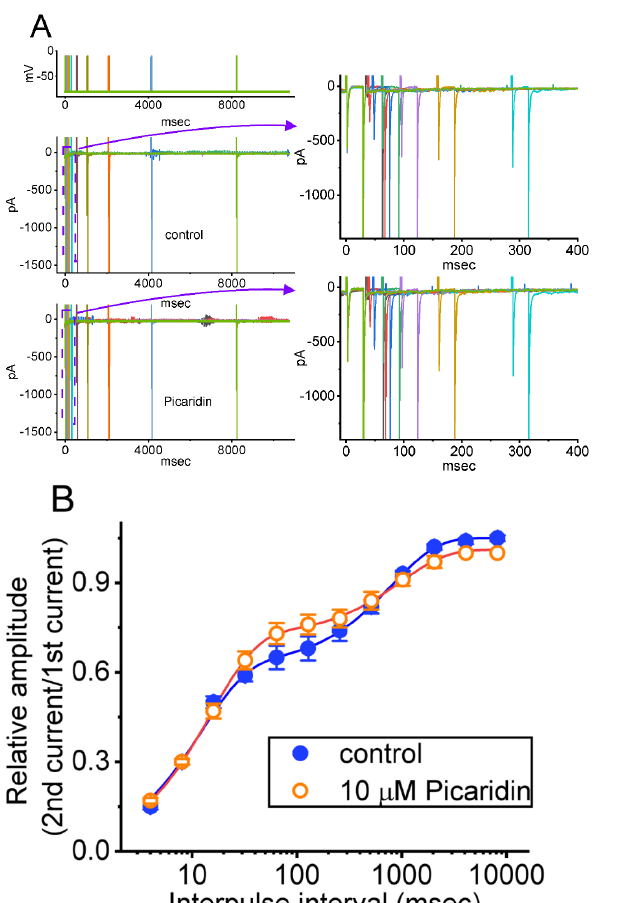
Figure 5. Modification by picaridin on the recovery of I Na (T) inactivation evoked by varying inter- pulse intervals following the conditioning train of depolarizing pulses. In these measurements, we kept GH 3ˇ cells bathed in Ca 2+ - free Tyrode’s solution, while the recording pipette was filled with a solution enriched with Cs + . The tested cells were depolarized from −80 to −10 mV for a duration of 30 ms, and subsequently variable inter-pulse durations with a geometric progression (indicated in the uppermost part) were imposed on them. ( A ) In our voltage-clamp protocol, the different colors indicated in current traces (lower) correspond with those in potential traces (upper). Exemplar current traces acquired in the absence (upper) and presence (lower) of 10 μM picaridin. Current traces in the right side show the expanded records from the purple dashed boxes with purple curve arrows in the left side for better illustrations, while the uppermost part is the voltage-clamp protocol applied. Brief inward deflection with a progressive rise with increasing inter-pulse interval showed the occurrence of I Na(T) activated by short depolarizing pulse. ( B ) The relationships of the relative amplitude of I Na(T) versus the inter-pulse interval acquired from the absence (blue filled circles) and presence (red open circles) of 10 µ M picaridin (mean ± SEM; n = 8 for each point). The smooth curve obtained with or without the presence of picaridin was least-squares fitted with a two-exponential function, as described in Materials and Methods. Of note, the x-axis is given in a logarithmic